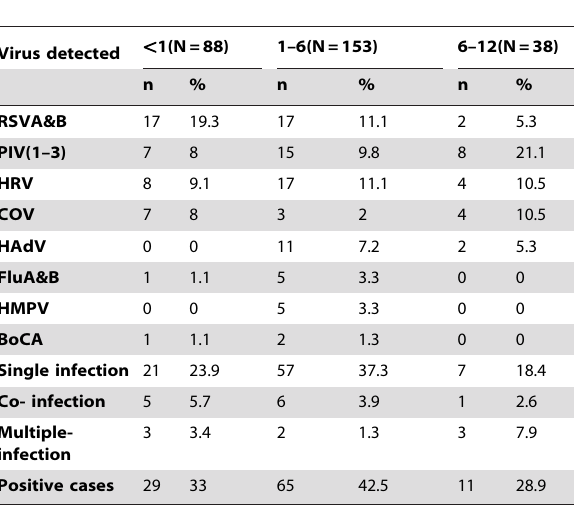
Table 3. Viral pathogens distribution in different age group.